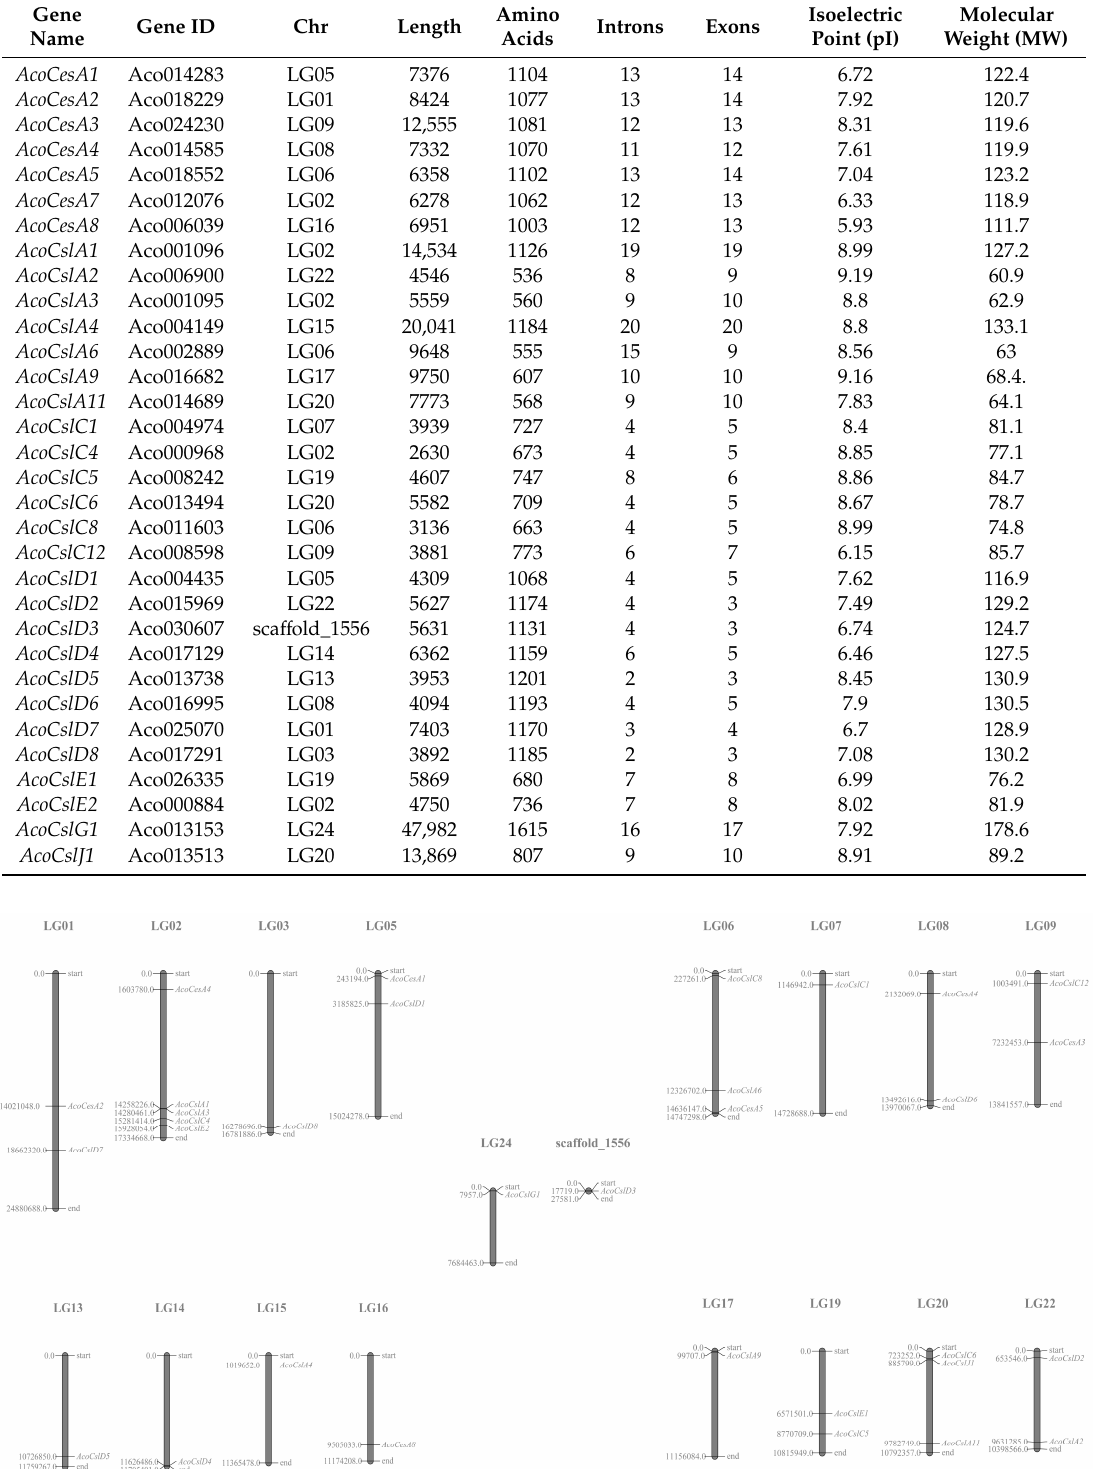
Table 1. Properties of the Ces / Csl gene superfamily in pineapple.